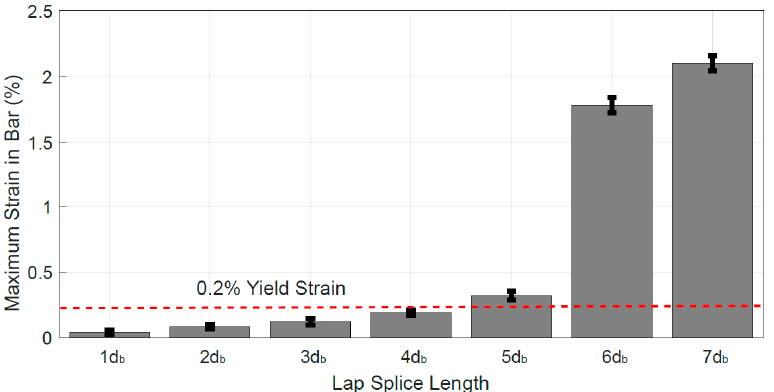
Figure 8. Modes of failure for lap splice: ( a ) bar slippage for lap splice length of 5d b ; ( b ) bar rupture for lap splice length of 7d b .